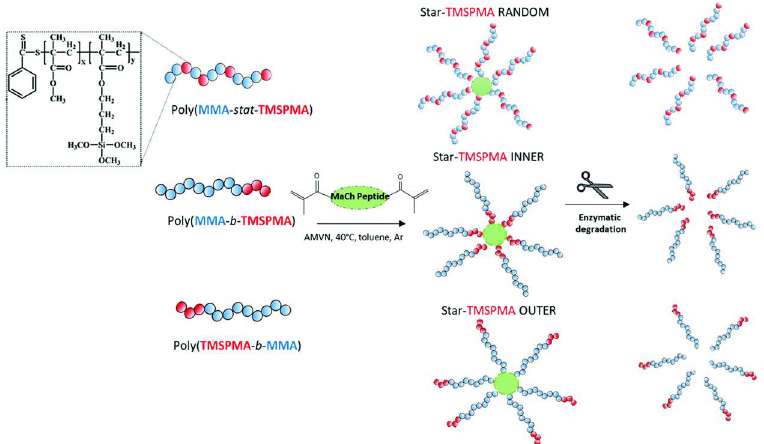
Figure 12. Schematic illustration of the poly(MMA-TMSPMA) star polymers synthesised with arms of three different architectures (random, inner and outer) crosslinked by an MaCh-peptide core and cleavage by collagenase activity. Reprinted with permission from [105].